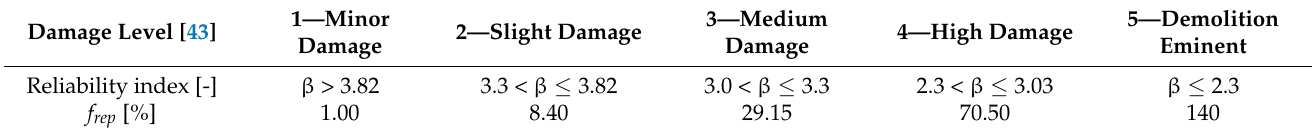
Table 3. Values for f rep based on